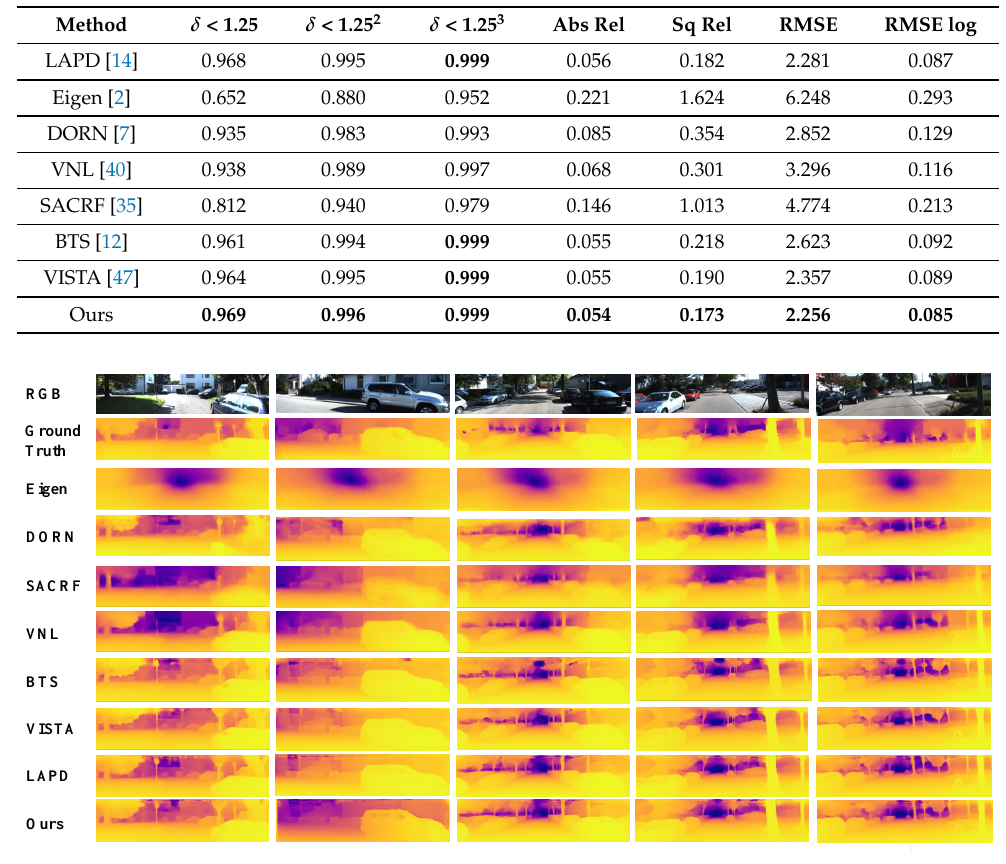
Figure 8. A visualization of the comparison results. Table 5. The overall comparison between the selected methods on the entire KITTI Dataset.